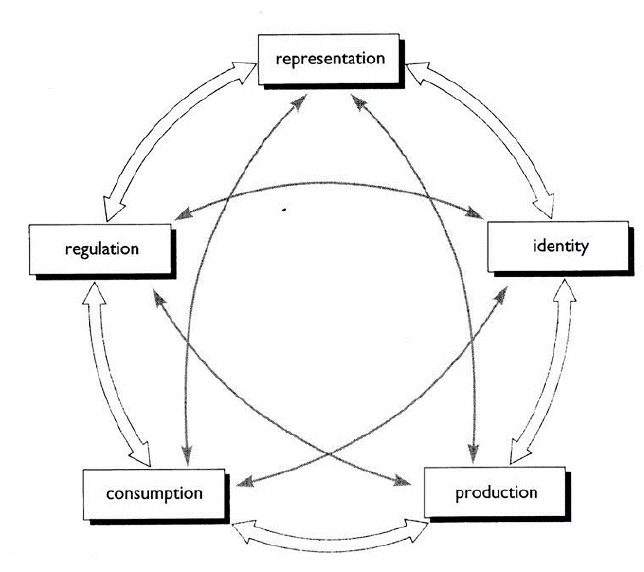
Figure 17. The Circuit of Culture (Hall